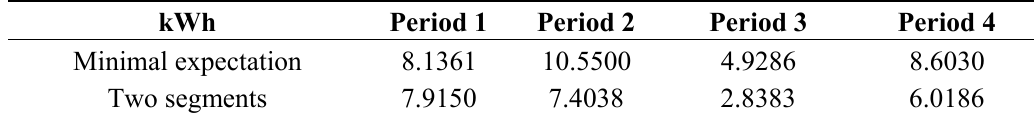
Table 2. Capacity of ESS comparison of the two methods.